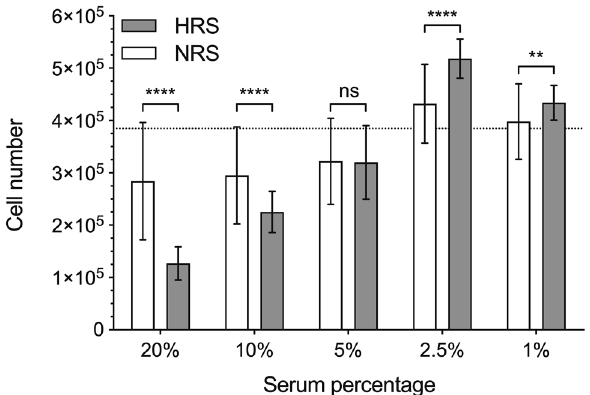
Figure 3. Proliferation curves of CC531 cell cultures enriched with low concentration of rat serum (normal rat serum, NRS: white; hepatectomized rat serum, HRS: grey). Dotted line represent cell numbers of cultures enriched with foetal calf serum (FCS). Figure and analysis were performed using GraphPad Prism version 6.04 for Windows, GraphPad Software, San Diego, California USA, www.graph